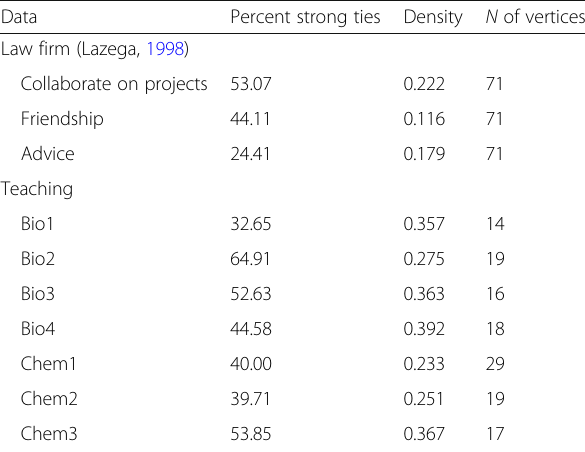
Table 2 Relative frequency of strong ties defined as reciprocated